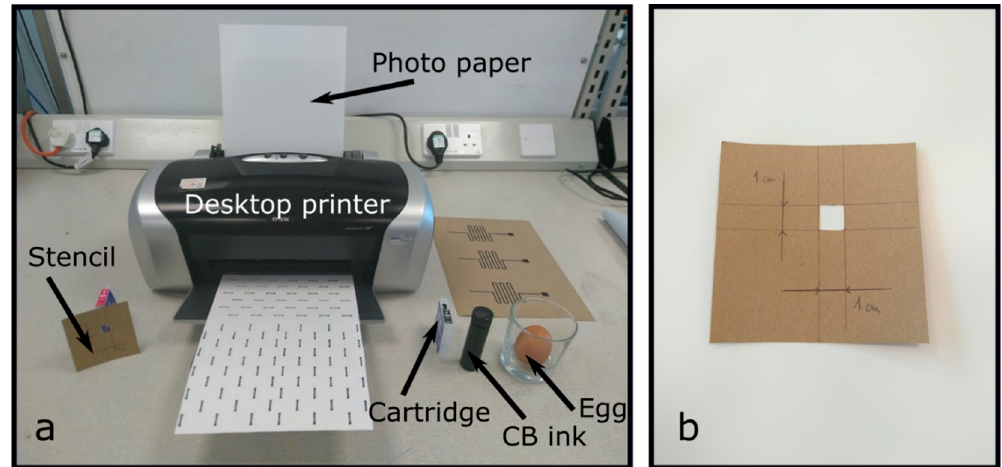
Figure A6. The equipment used for Do-It-Yourself printing of the RC filter. ( a ) General view of the required apparatus and ( b ) detail of the stencil used for the screen printing of the egg white. Example line prints and resistors on the white and brown paper observed in the image.